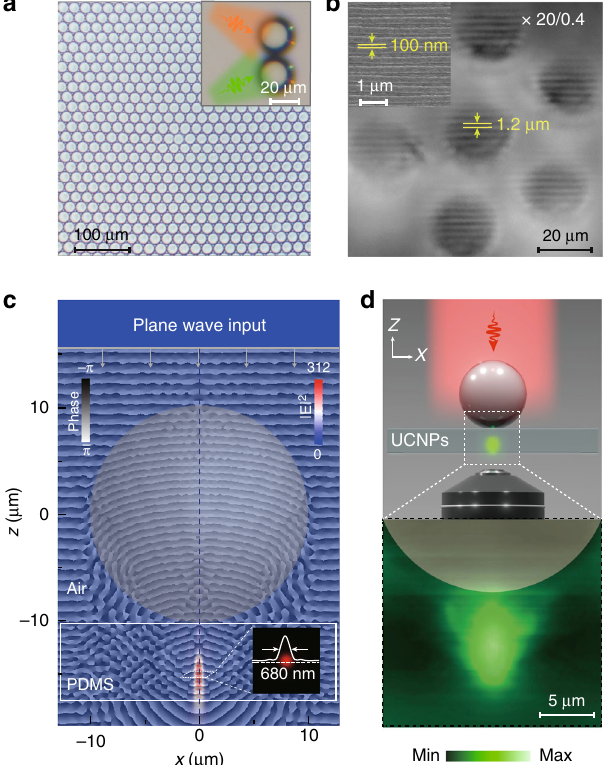
Fig. 1 Superlensing effects of polymeric microbeads. a Photographic image of the as-prepared PEGDA polymeric microbeads using the micro fl uidic technique. (Inset) Photographic image showing the convergence of two intersected orange and green LED beams into two small focal spots after passing through the microbeads sitting on a glass substrate. b Microbead- guided high-resolution optical imaging of a blue-ray disk showing periodic line patterns of ~100 nm. (Inset) Scanning electron microscopic imaging of the disk. c FDTD simulation of the electric fi eld distribution and phase variation of NIR excitation light after passing through the dielectric microbead. Note that a 980-nm plane wave light source is used for excitation and images of electric fi eld distribution and absolute phase mapping are merged. (Inset) Cross-section feature of electric fi eld at the focal spot. d Demonstration of the existence of the photonic hotspot in the UCNP-embedded polydimethylsiloxane (PDMS) fi lm. Here, the NaYF 4 :Yb/ Er-embedded PDMS substrate is placed underneath a 20 μ m dielectric microbead and a 980 nm laser beam is used for illumination. A confocal microscope was used to record the distribution of luminescence intensity through 3D